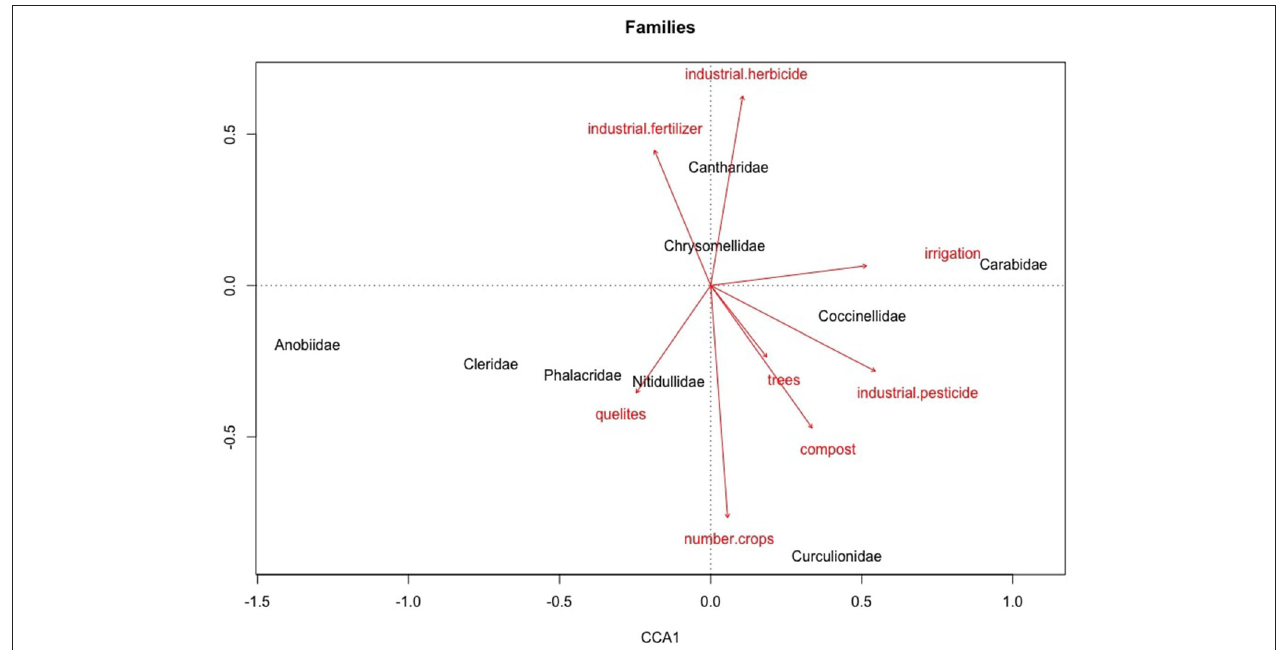
FIGURE 7 | Canonical correlation analysis of management practices and the best represented beetle families.